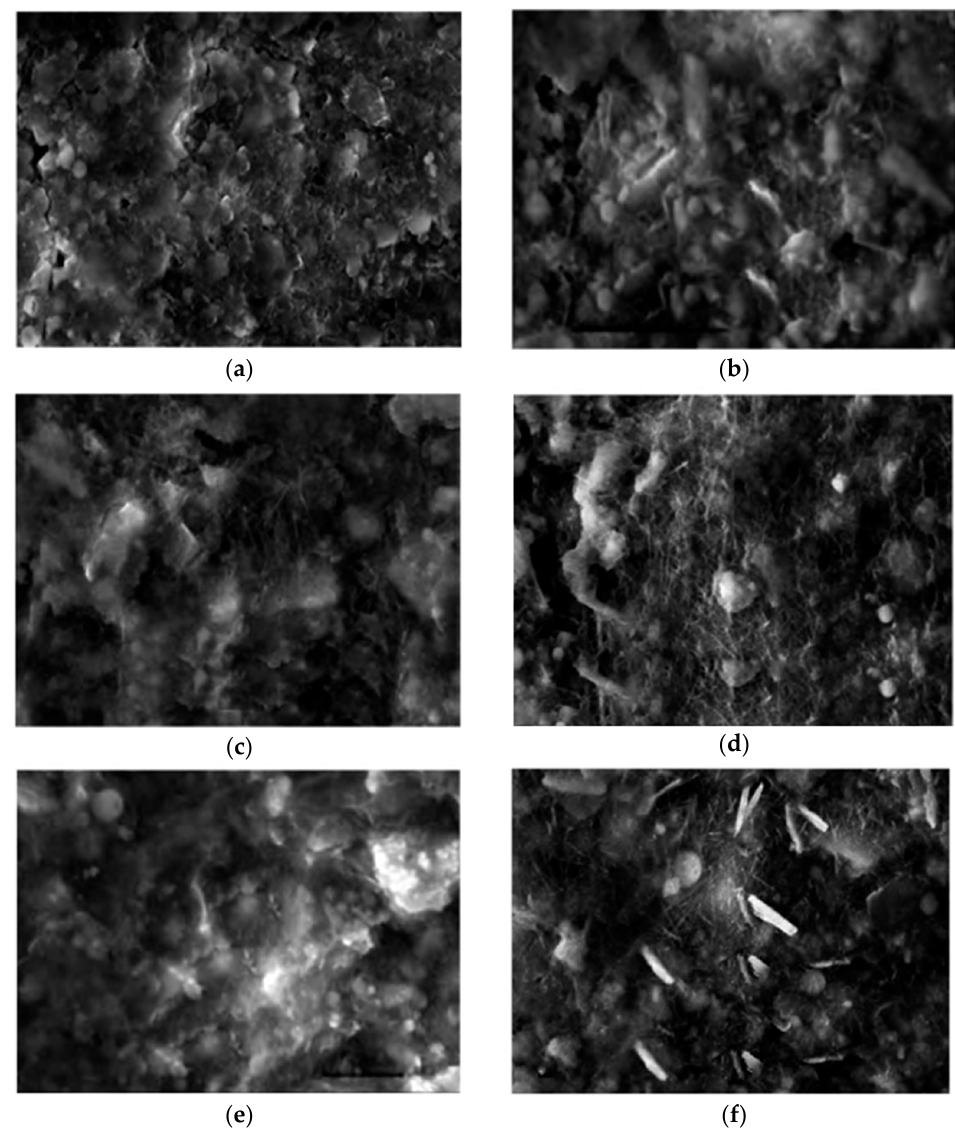
Figure 7. SEM images of mortar containing 40% recycled powder at 90d excitation with different activators. ( a ) Without activator, ( b ) NaOH activator, ( c ) Ca(OH) 2 activator, ( d ) Na 2 SO 4 activator, ( e ) CaSO 4 ·2H 2 O activator, ( f ) CaCl 2 activator.